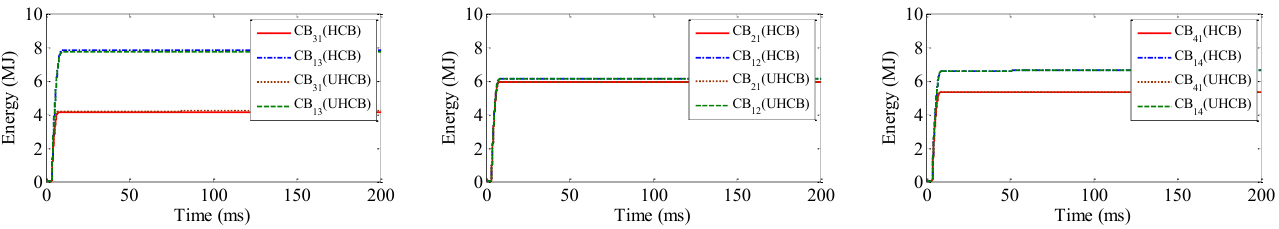
Fig. 7. Absorbed energy in surge arresters of BCBs and UCBs (a) CB 13 and CB 31 , (b) CB 12 and CB 21 , (c) CB 14 and CB 41